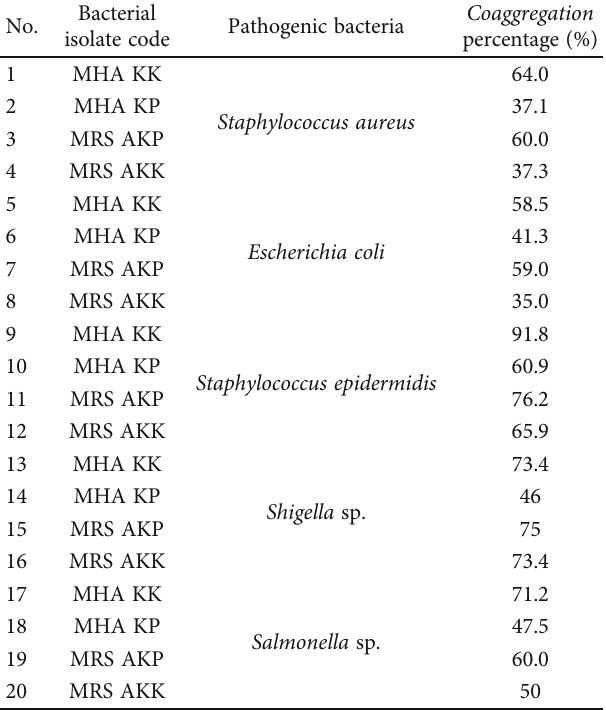
Table 4: Coaggregation test